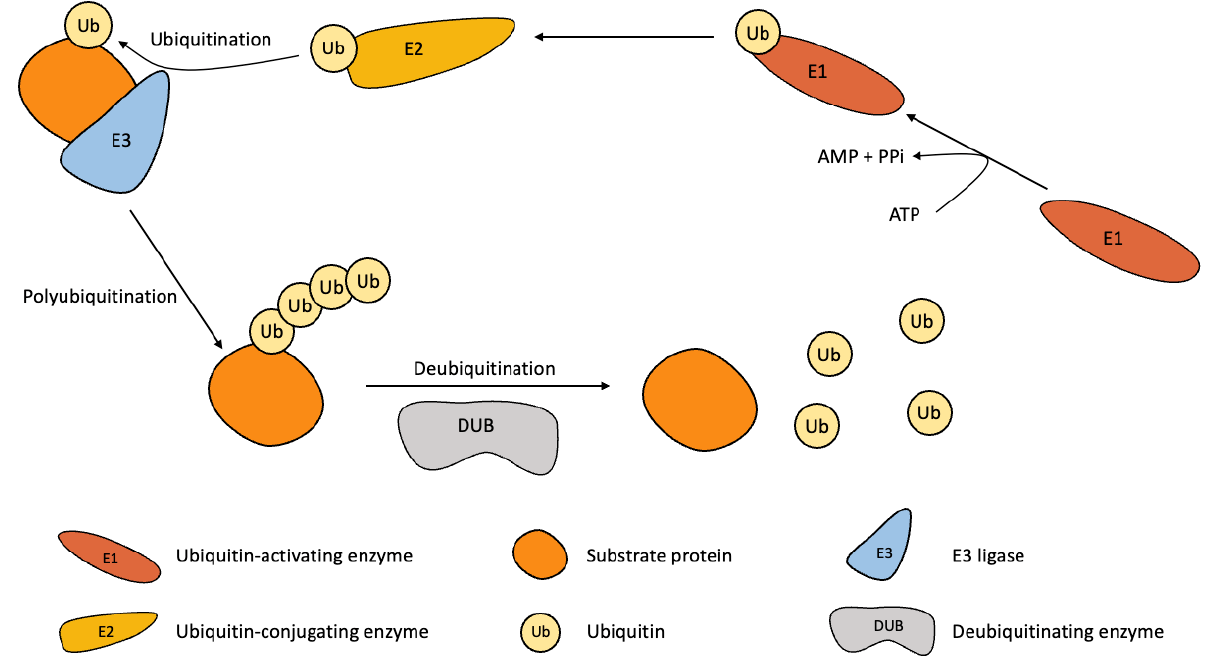
Figure 1. A mechanism of the ubiquitination and deubiquitination. The substrate is ubiquitinated by the E1 ubiquitin-activating enzyme, E2 ubiquitin-conjugating enzyme, and E3 ligase. The polyubiquitin chain is formed by successive mechanisms. A substrate with polyubiquitin chains regulates various cellular functions. Conversely, the polyubiquitin chain of the substrate is cleaved by the DUB.